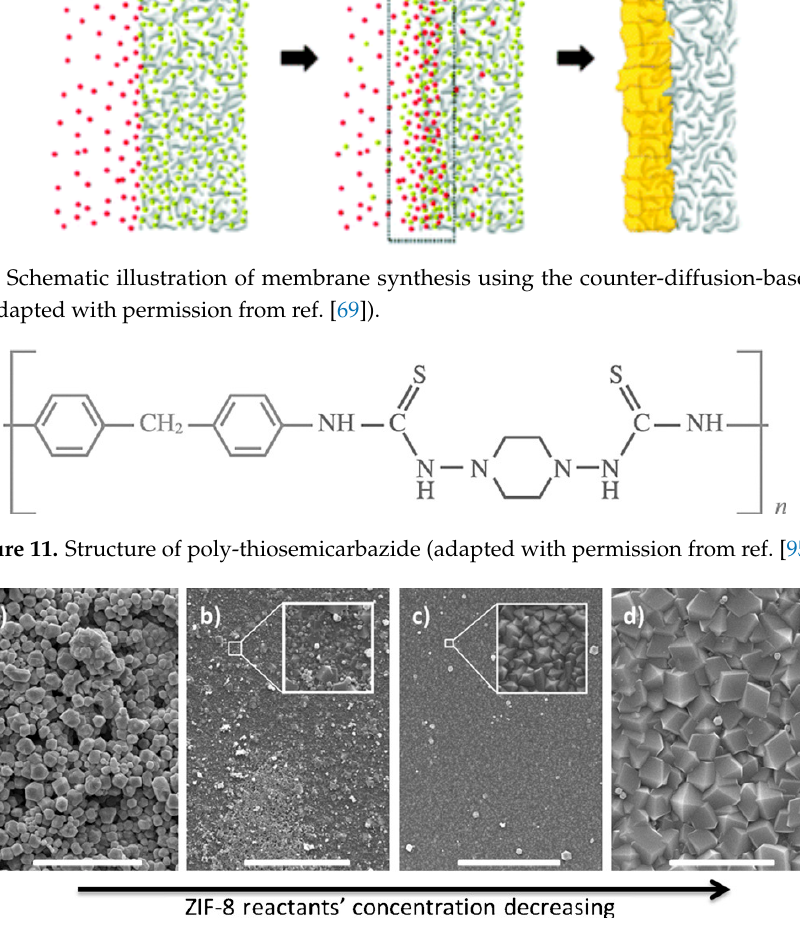
Figure 12. SEM surface images of ZIF-8/PTSC membranes prepared with different reactant concentrations: ( a ) M1, ( b ) M2, ( c ) M3, and ( d ) M4. Scale bar: 10 mm (adapted with permission from ref.